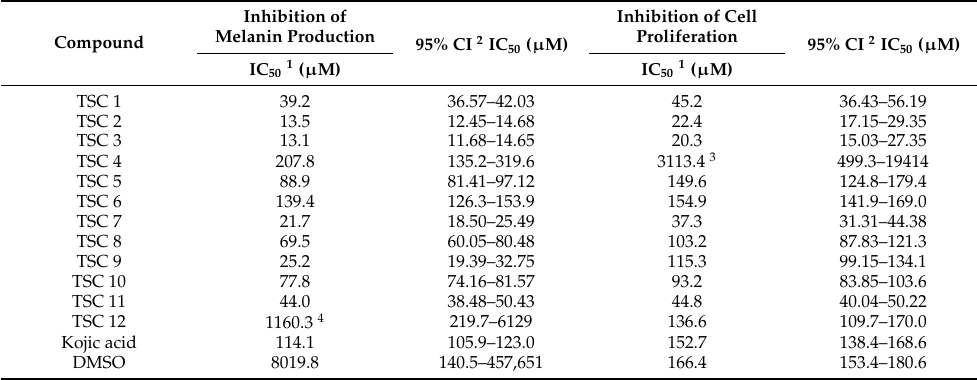
Table 3. Effectiveness of TSCs in inhibition of melanin production and B16F10 cell